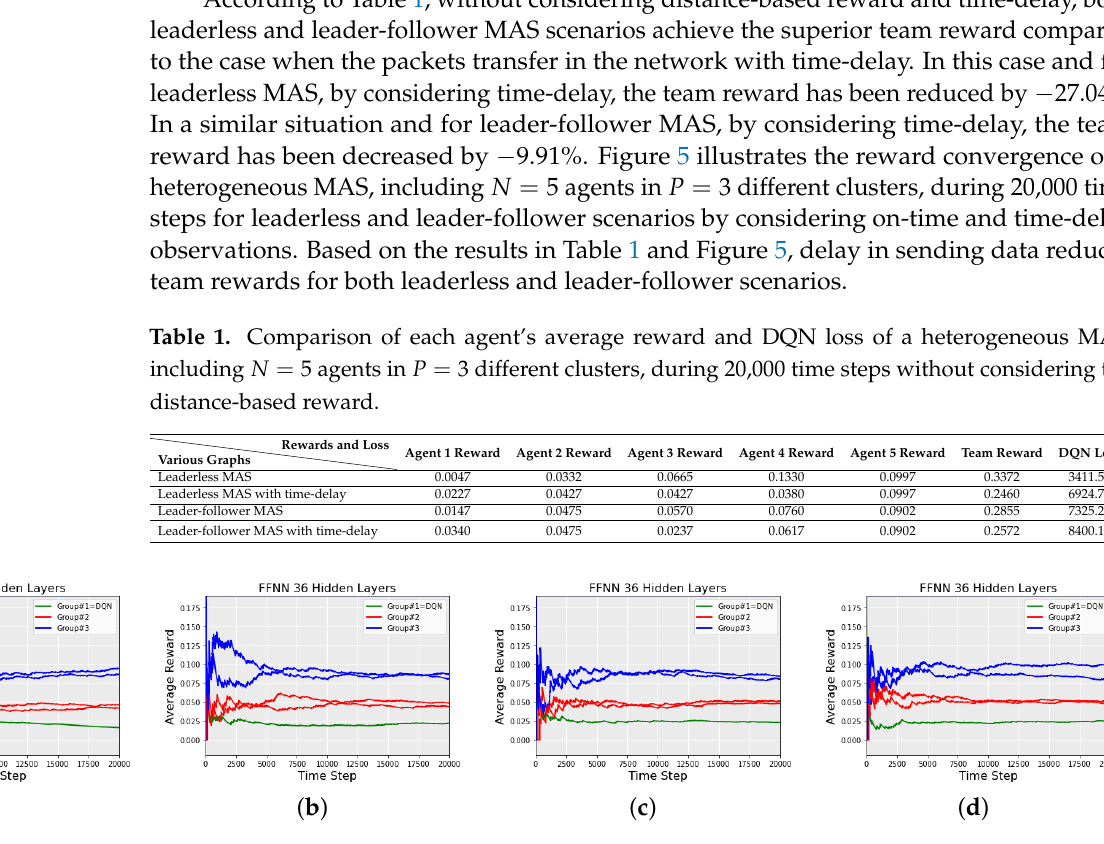
Figure 5. Reward convergence of a heterogeneous MAS, including N = 5 agents in P = 3 different clusters, during 20,000 time steps. ( a ) Average reward of a leaderless MAS. ( b ) Average reward of a leaderless MAS by considering time-delay. ( c ) Average reward of a leader-follower MAS. ( d ) Average reward of a leader-follower MAS by considering